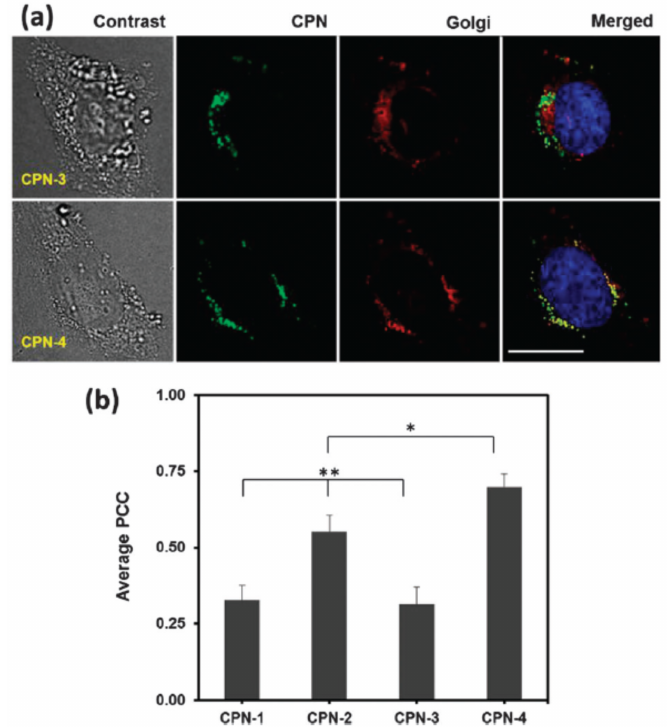
Figure 8. ( a ) Microscopic images of HeLa cells incubated with CPNP-3 and CPNP-4, followed by Golgi (red) and nucleus (blue) staining. The scale bar is 20 µ m. CPNP-4 exhibits a higher overlap with Golgi than CPNP-3; ( b ) quantitative analysis of co-localization using the PCC (Pearson’s correlation coefficient) algorithm. Co-localization with Golgi is dependent on the side chain and backbone structures. The error bar represents ± standard deviation ( n = 3). * <0.05 when CPNP-4 compared with CPN-2. ** <0.0005 when CPNP-1 and CPNP-3 are compared with CPNP-2 and CPNP-4 ( n = 3). Reproduced with permission [55]. Copyright: 2013, Royal Society of Chemistry.